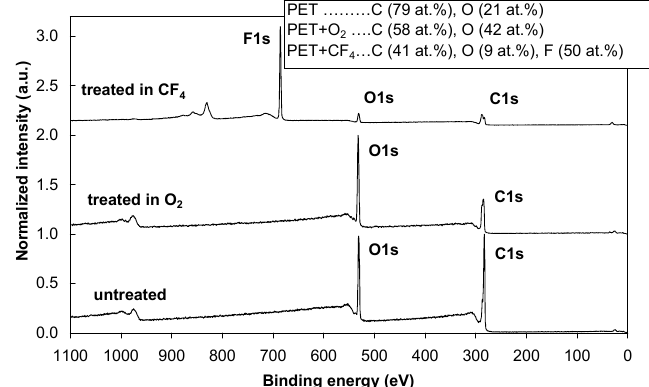
Figure 1. XPS survey spectra for the control (untreated) PET sample and for PET samples treated in O and CF 2 4